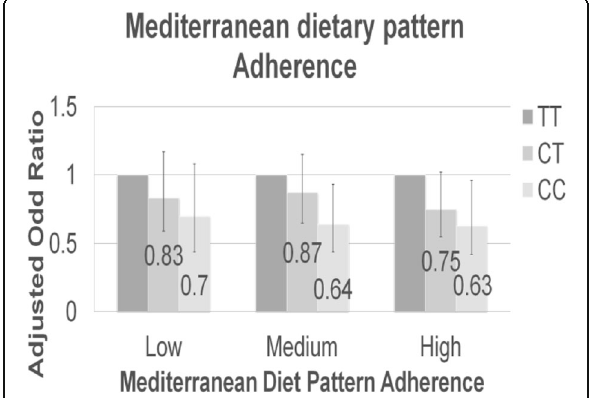
Fig. 3 Association between SNP rs4939827 and the Mediterranean dietary pattern adherence in relation with colorectal cancer taking into account the genotype. Reference: TT genotype. Vertical axis: Adjusted Odd Ratio (The adjusted odds ratios (OR) was calculating taking into account the variables sex, age, socioeconomic level, BMI, total energy intake, family history fist degree, METS and area was used as random variable). Abscissa axis: Mediterranean Diet Pattern